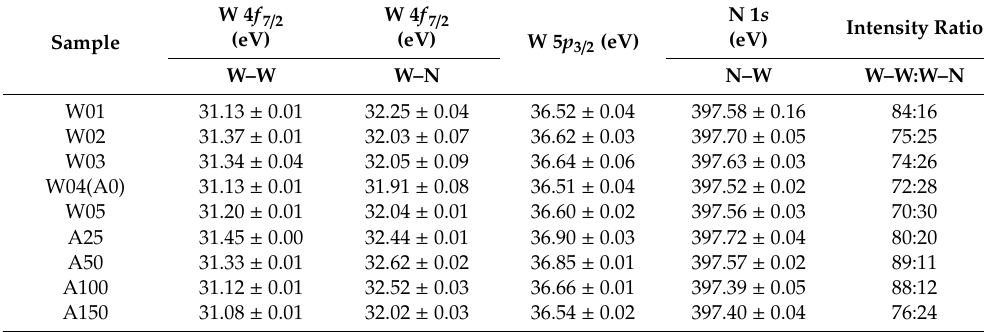
Table 3. Mechanical properties of W–N